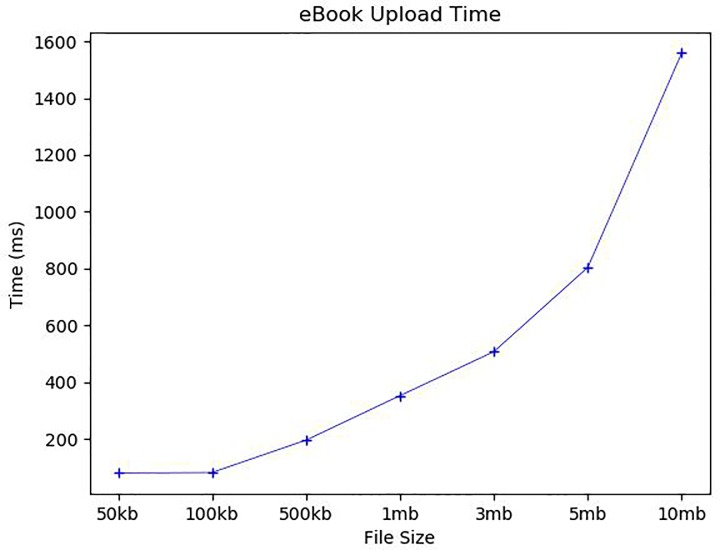
eBook upload time.